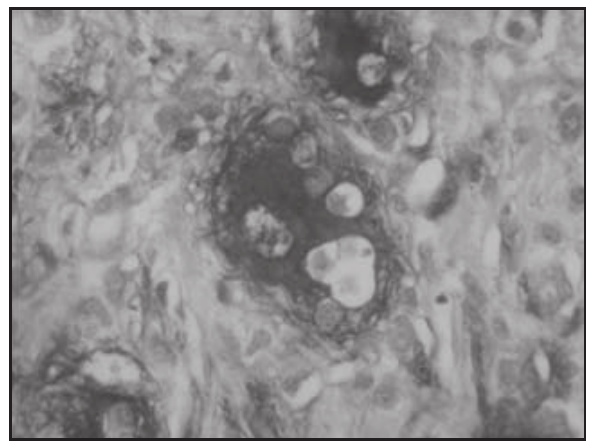
Figure 4 – S-100 expression in a large histiocyte with emperipolesis (anti-S100 antibody, DAKO, streptavidin-peroxidase conjugate, 1,000x